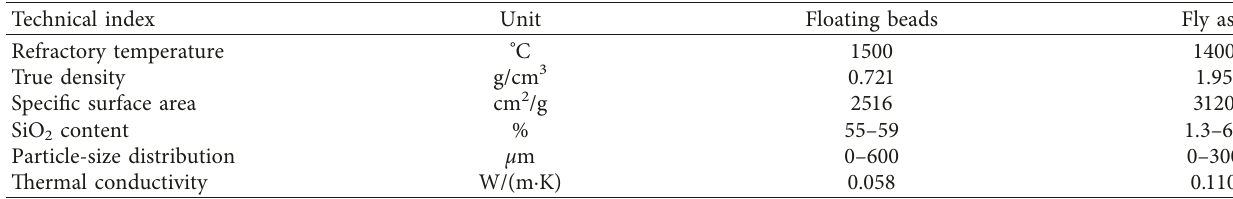
Table 2: Major performance indexes of FB used in the